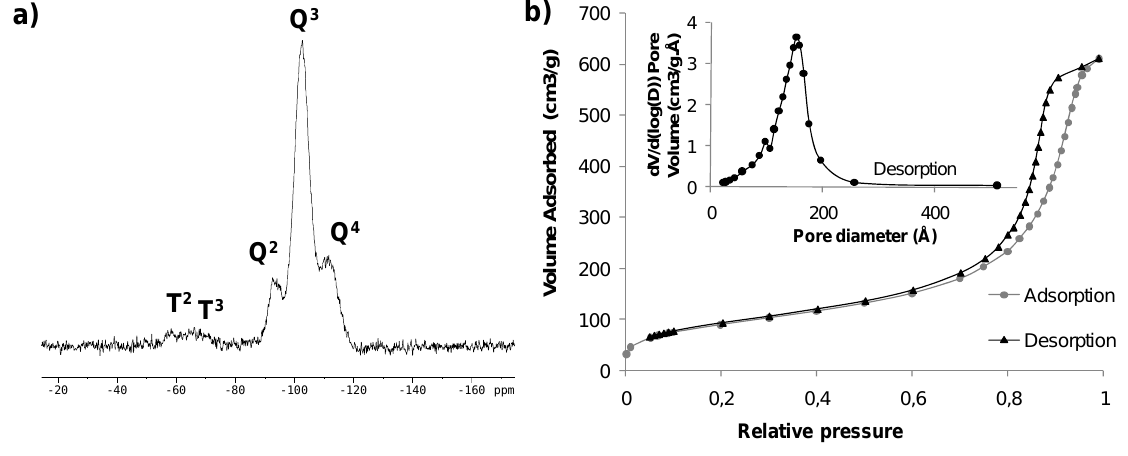
Figure 2. (a) Solid state CP-MAS 29 Si NMR spectrum of M1 . (b) N M1 and plot of the pore size